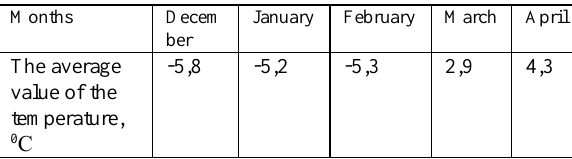
Table 2. The average value of the temperature